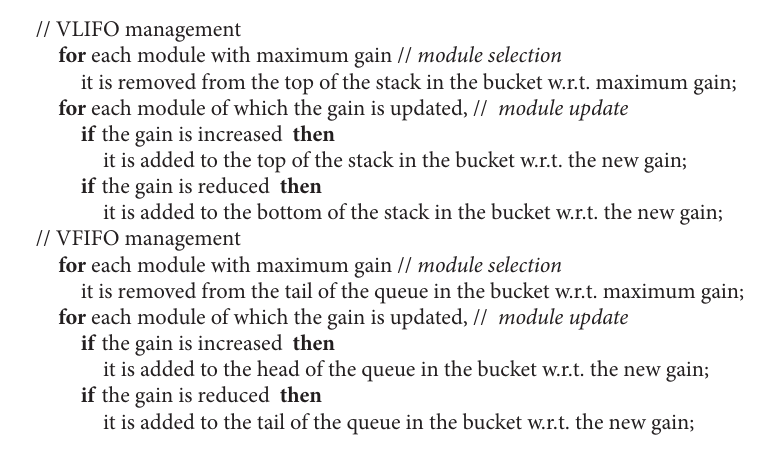
Algorithm 3: Pseudocodes of VLIFO and VFIFO management of gain buckets.